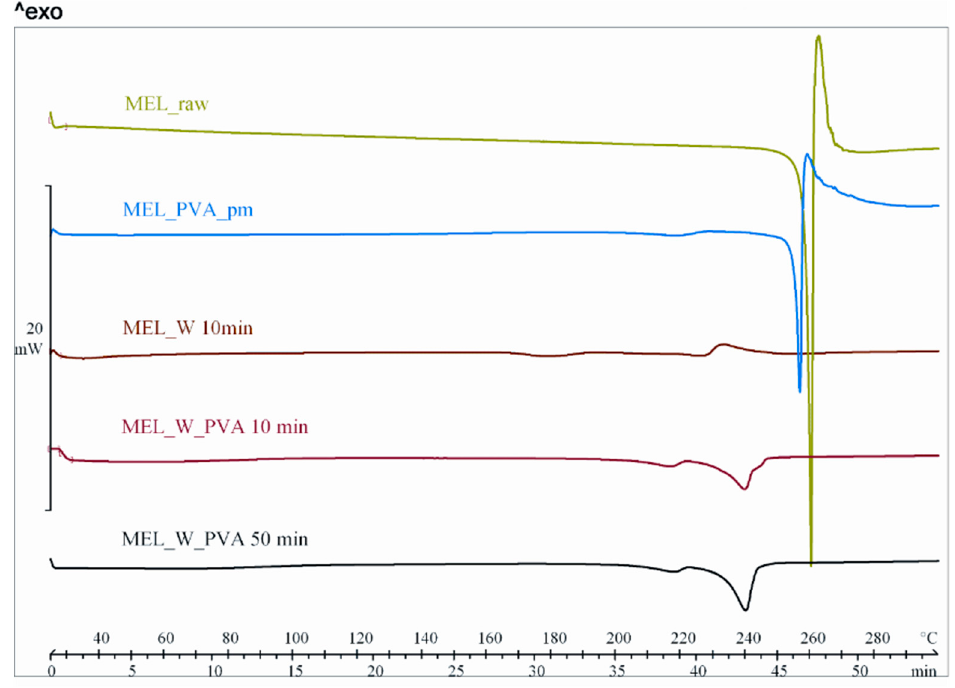
Figure 3. DSC curves of MEL_raw, MEL_PVA_pm, MEL_W 10 min, MEL_W_PVA 10 min and MEL_W_PVA 50 min. Table 4. Thermoanalytical evaluation of MEL_raw, MEL_PVA_pm and dried milled products.